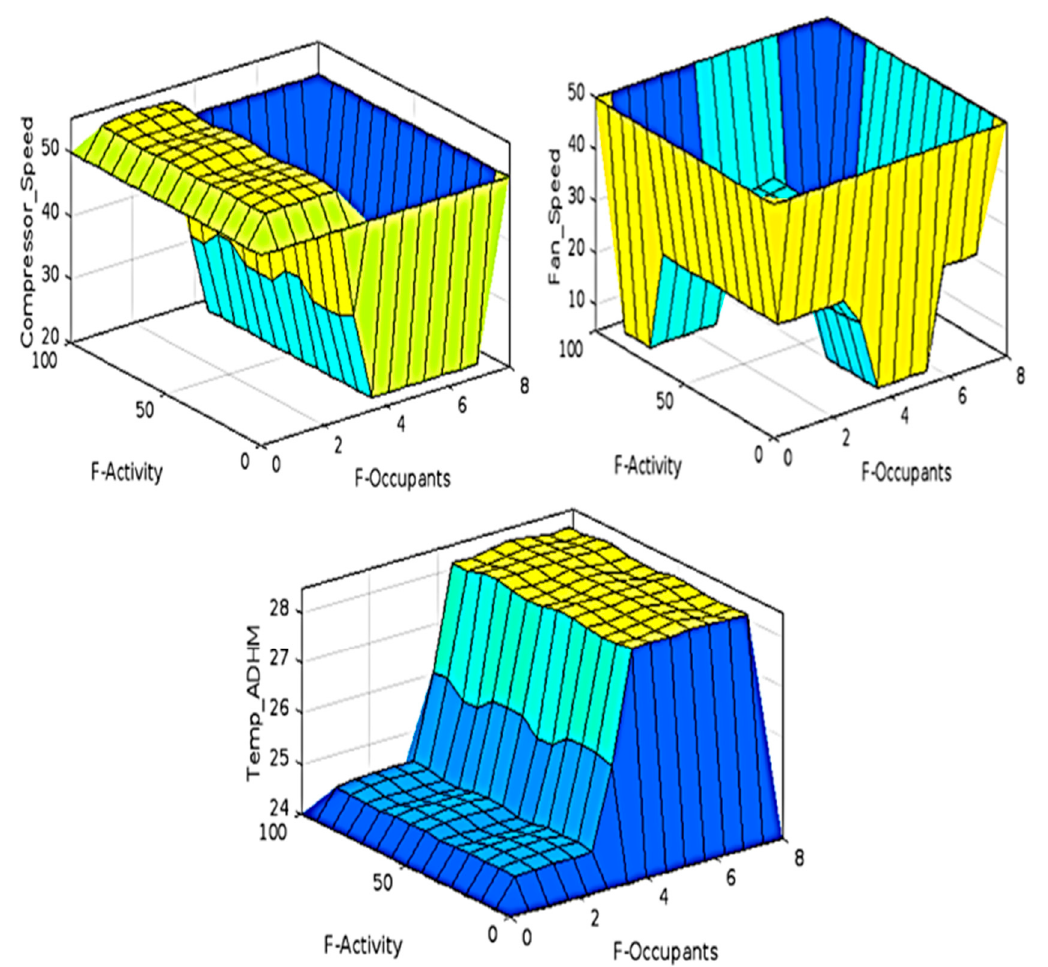
Figure 5. Surface viewer of compressor speed, fan speed, and temperature in relation to F-occupants and F-activity (falsity).